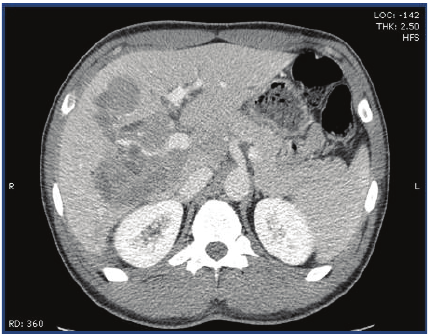
Figure 1: CT scan with intravenous contrast-portal venous phase showing multiple lesions in the liver.